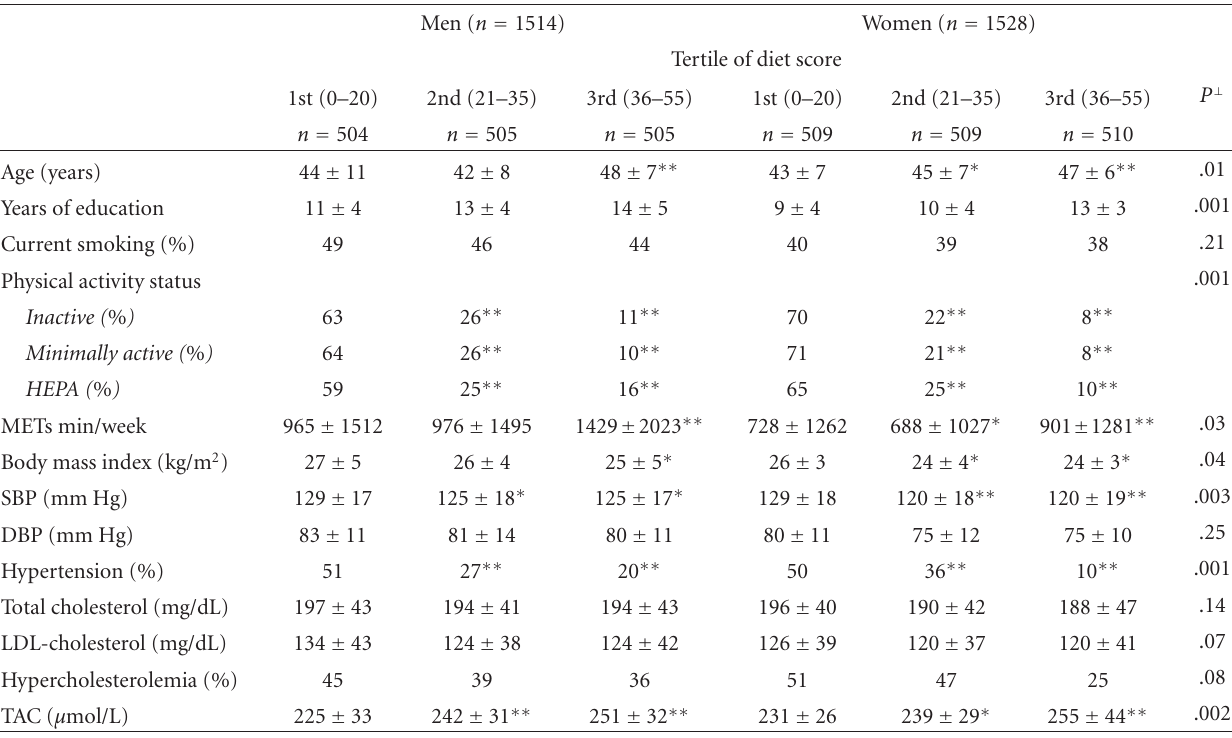
Table 1: Lifestyle, clinical, and biochemical characteristics of the participants, according to Mediterranean diet score.